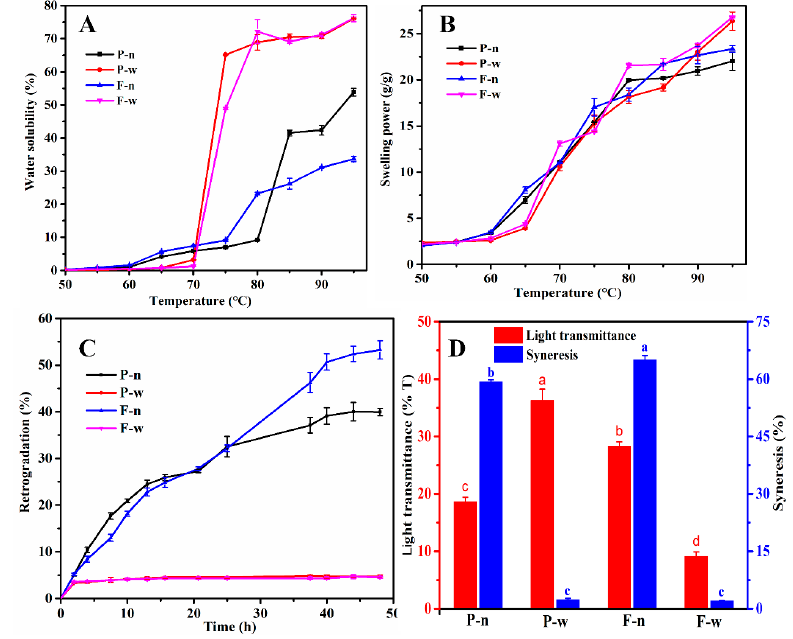
Figure 4. Physical properties of starches. ( A ), Water solubility of starch; ( B ), swelling power of starch; ( C ), retrogradation of starch; ( D ), light transmittance and freeze–thaw stability of starch.